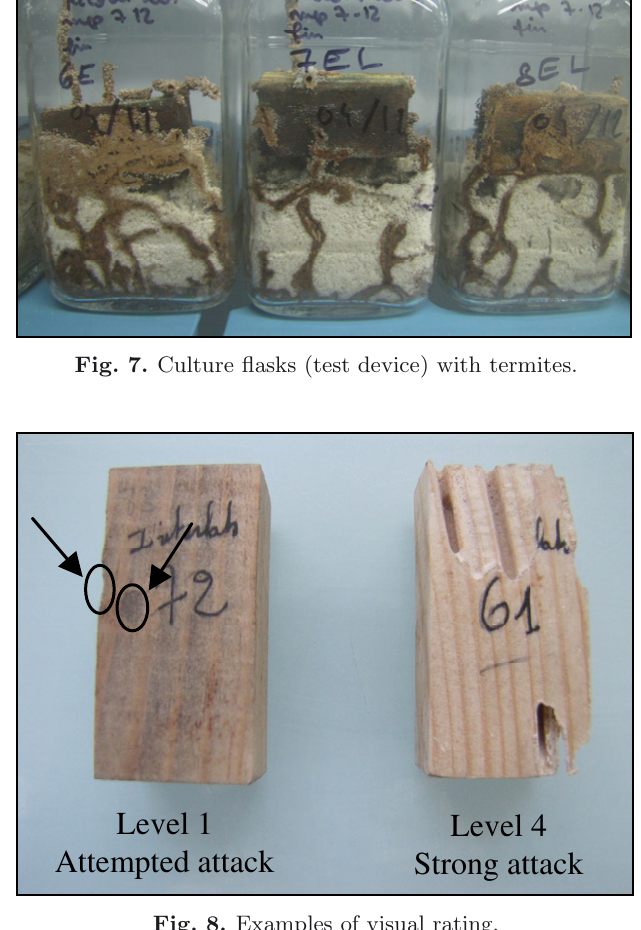
Fig. 8. Examples of visual